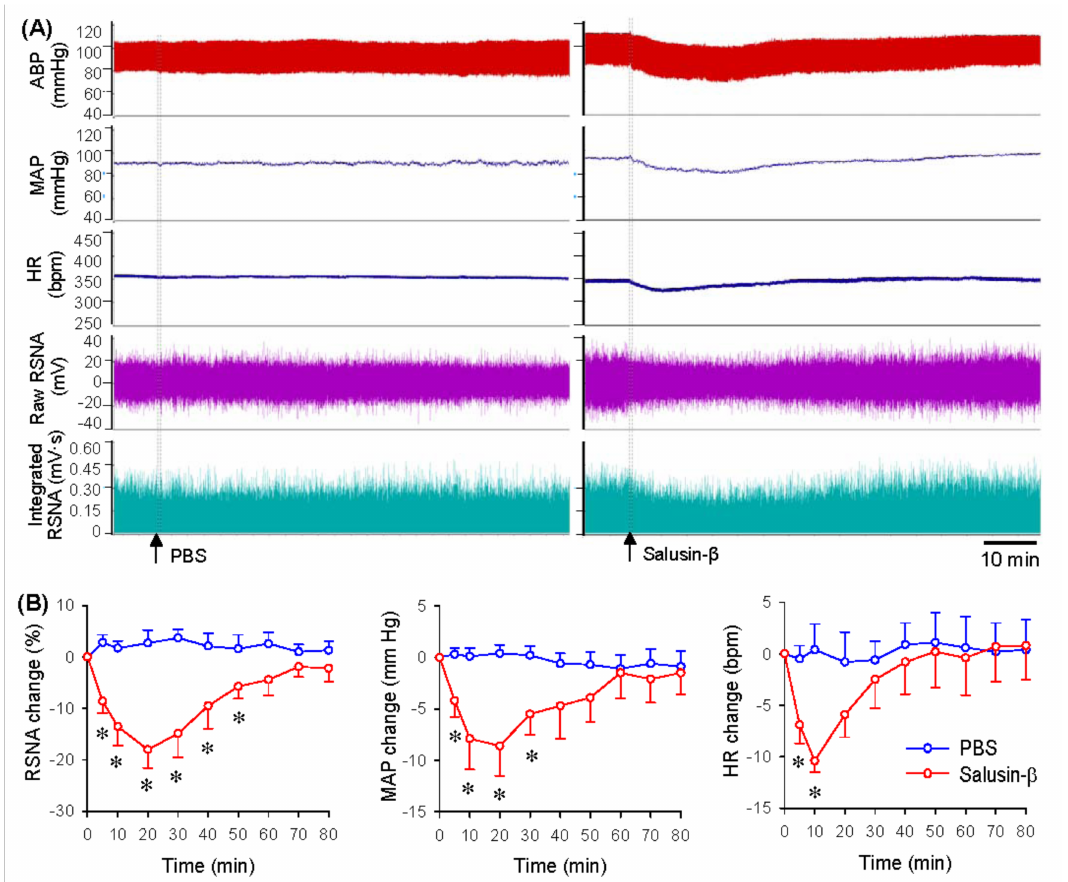
Figure 2. Time-effects of salusin- β in iDMV on RSNA, MAP and HR. ( A ) Representative recordings showing the effects of microinjection of PBS and salusin- β (100 pmol) in iDMV. ( B ) Line graph showing the time-effects of microinjection of PBS and salusin- β (100 pmol) in iDMV. * p < 0.05 vs. PBS. n = 6 per group.